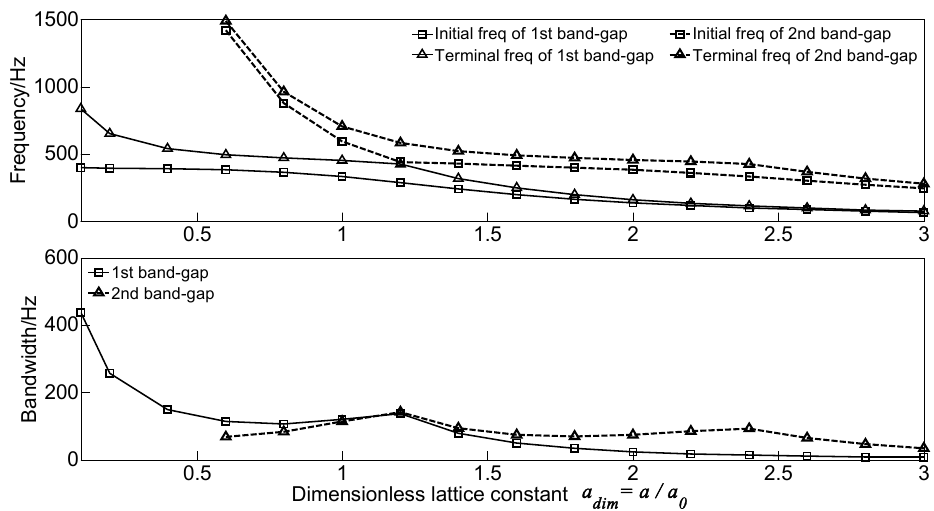
Figure 7. Band gaps maps as functions of dimensionless lattice constant a dim .